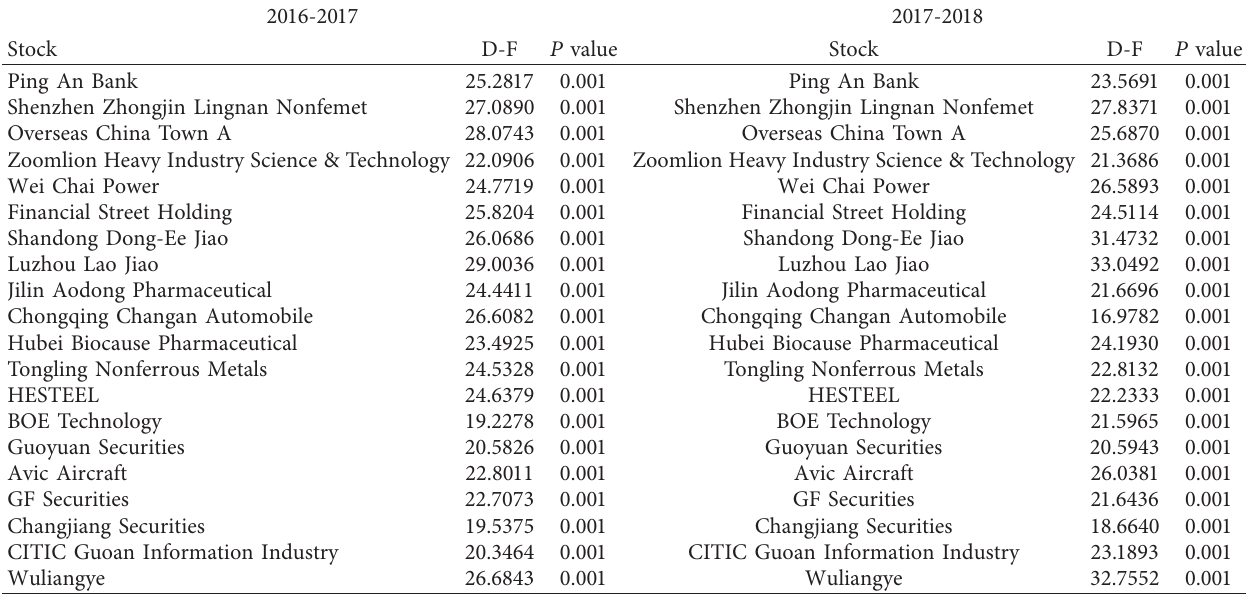
Table 1: ADF test of selected stocks during 2016-2017 and 2017-2018.